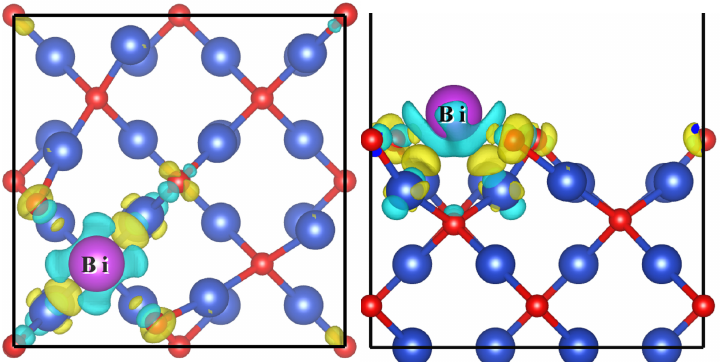
Figure 6. The charge density difference of Bi adsorbed Cu 2 O(100) surface with a coverage of 0.25 ML. Electron accumulation and depletion are represented by yellow and cyan-blue areas, respectively. The isosurface value is set as 0.008 e/Bohr 3